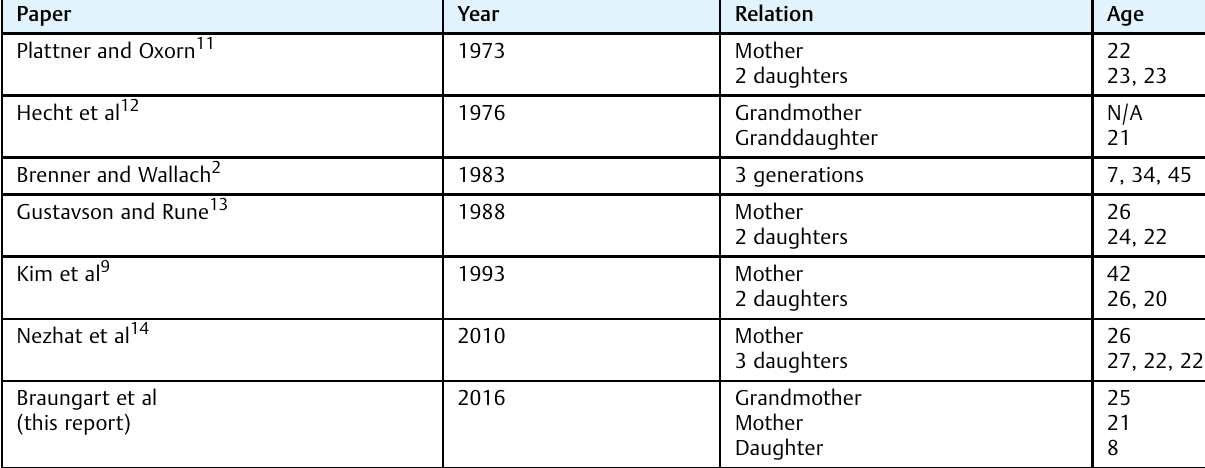
Table 1 Familial ovarian teratoma: summary of reported occurrences across several generations